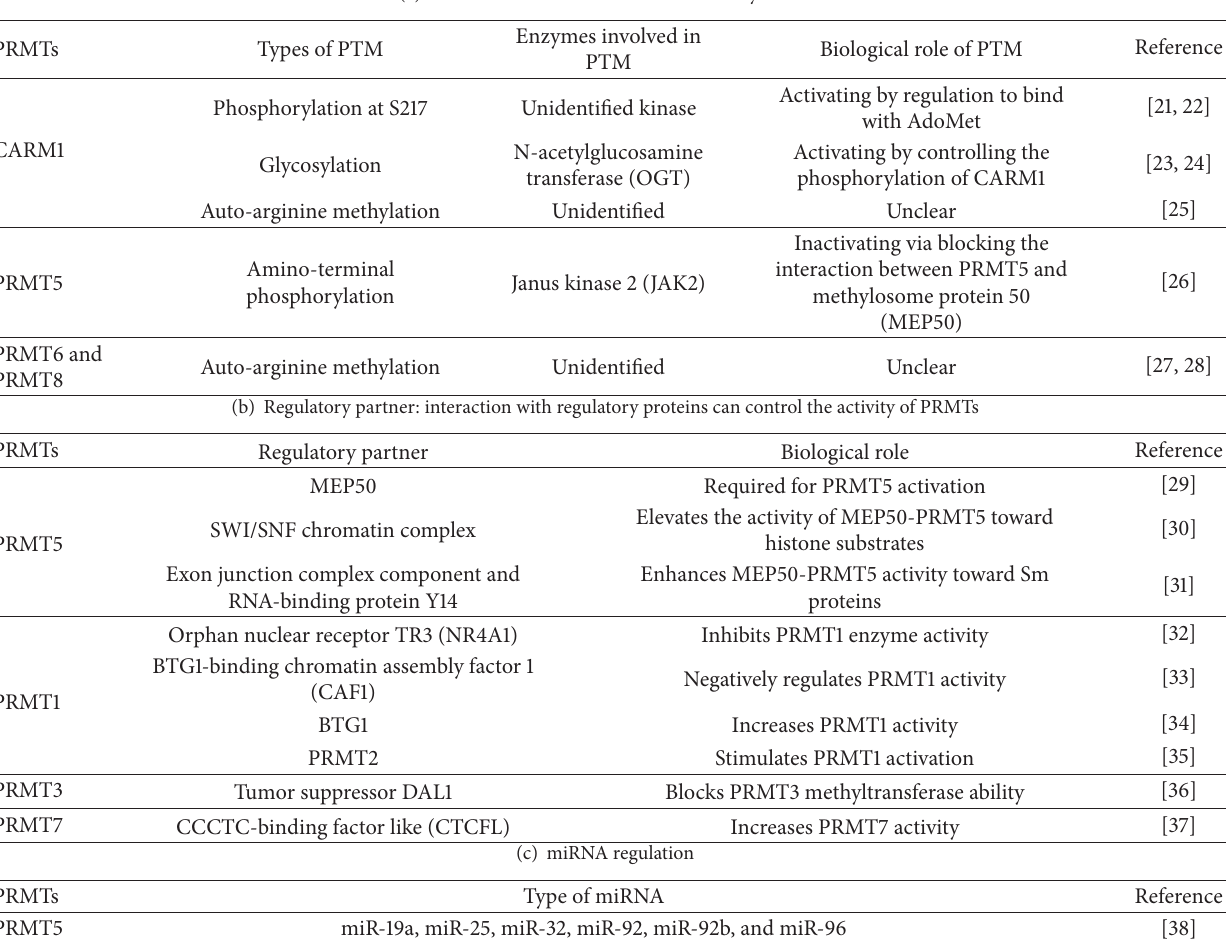
Table 3: Regulatory mechanisms of